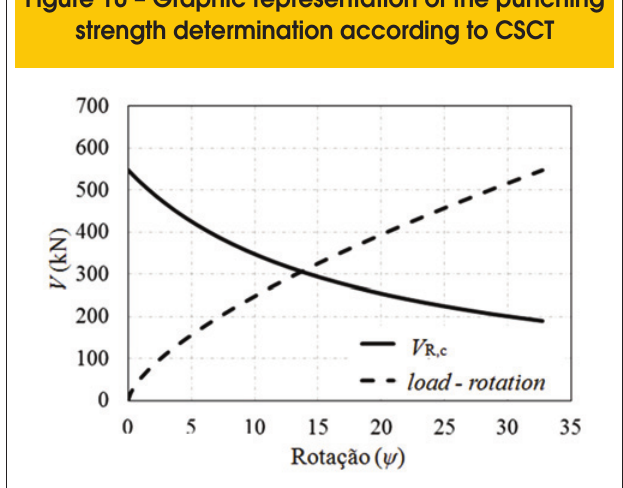
Figure �� � �raphic representation of the punching strength determination according to